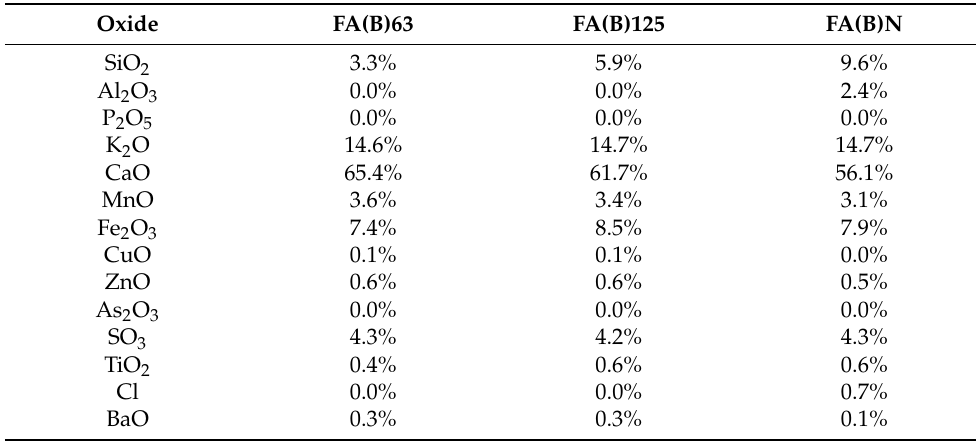
Table 6. Chemical oxide composition of sieved biomass fly ash.